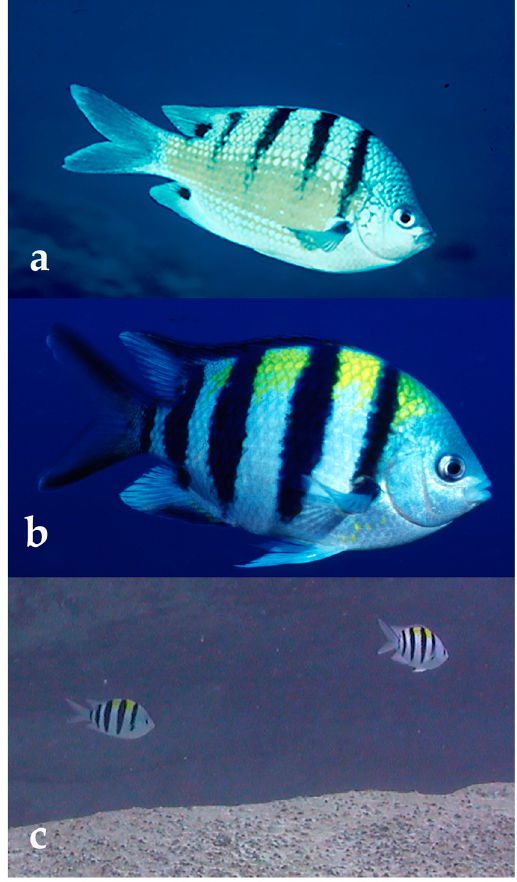
Figure 7. The pomacentrids at Johnston Atoll, Abudefduf abdominalis ( a ), A. vaigiensis ( b ) and ( c ) presumptive hybrids (Buoy 14, March 2001). Table 2. Abudefduf species colonization chronology.